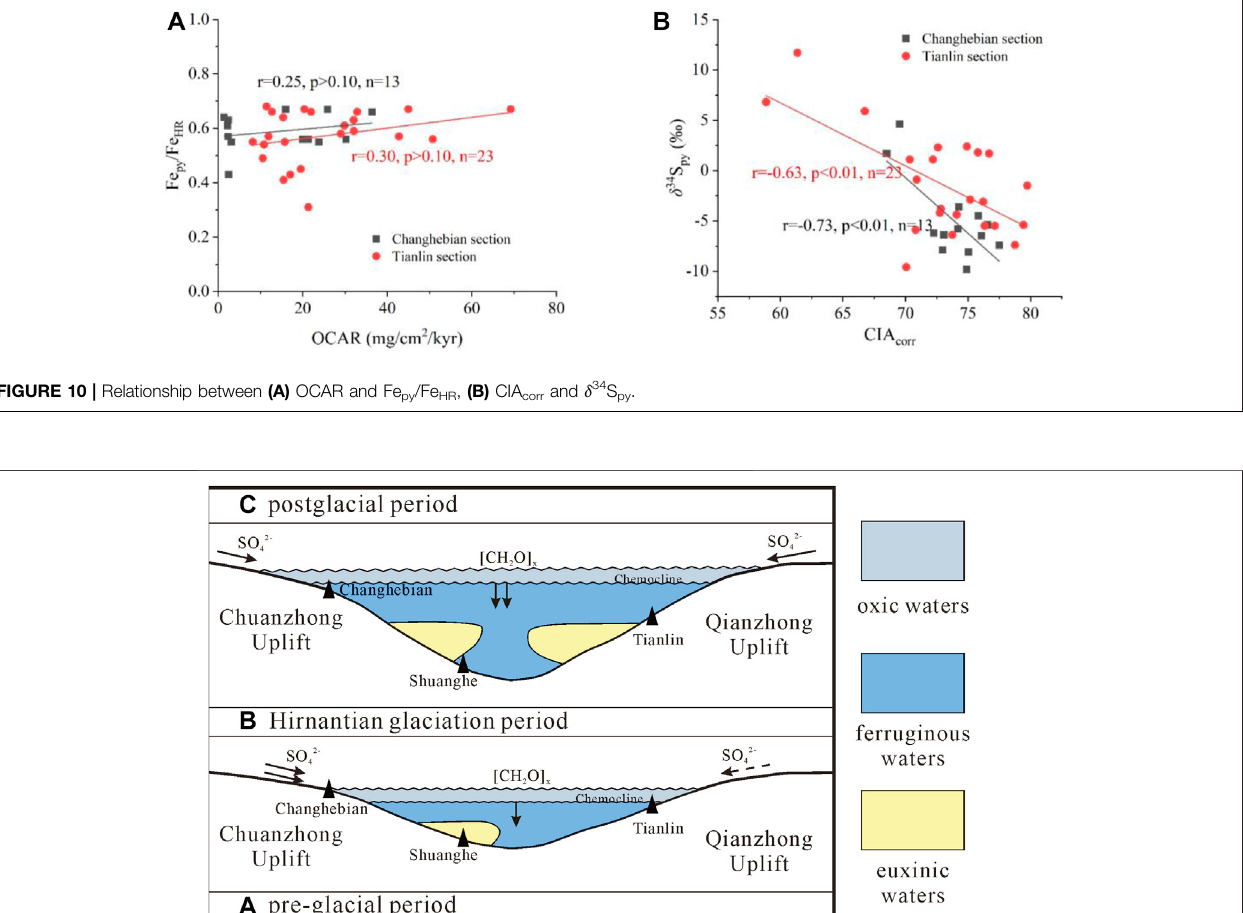
Frontiers in Earth Science |